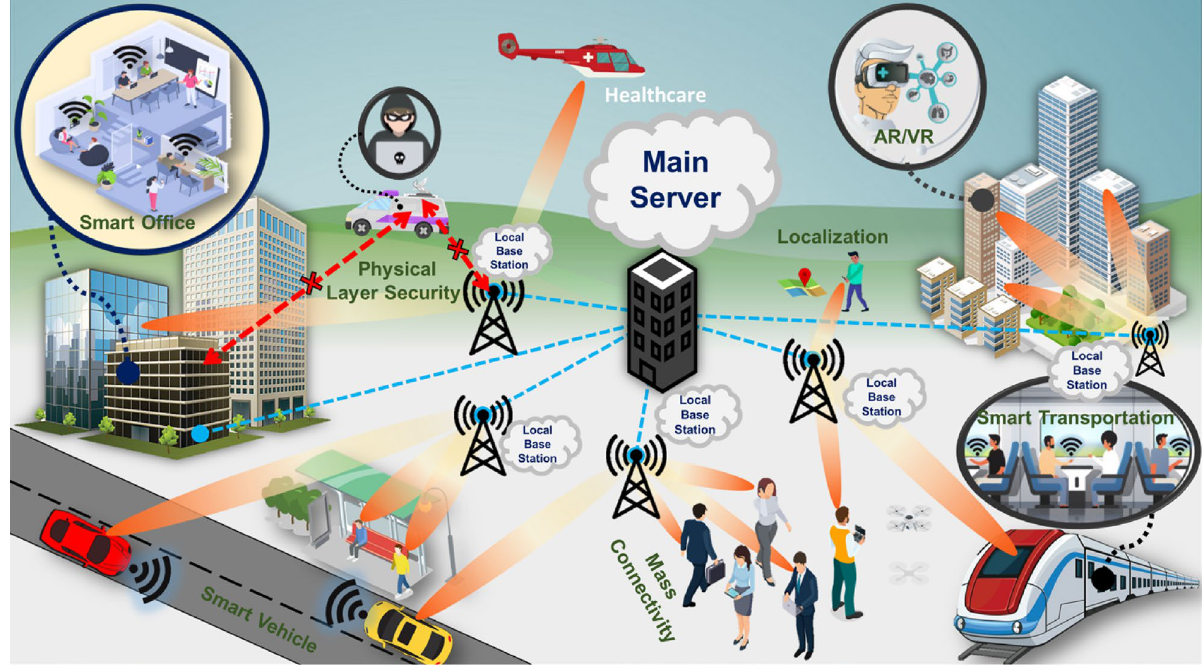
Figure 1. Next-generation communication systems in smart